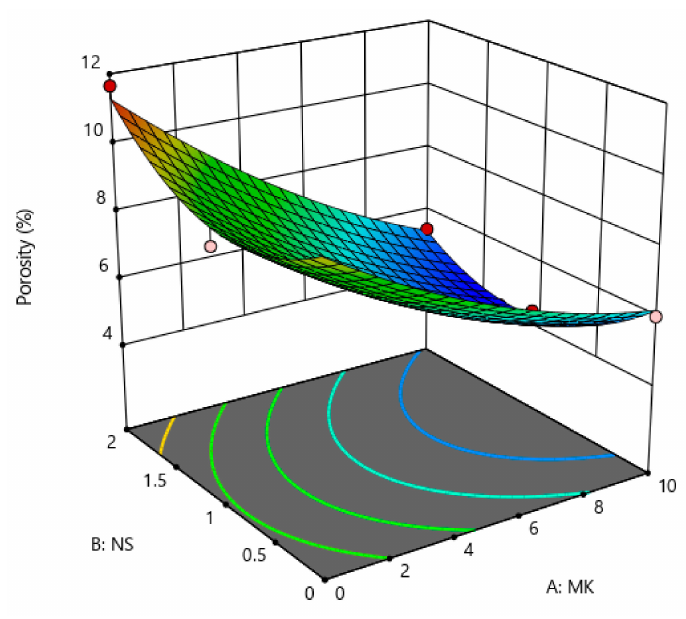
Figure 16. E ff ect MK and NS proportions on porosity. Table 6. Definitions of factors and responses in the multi-objective optimization problem.